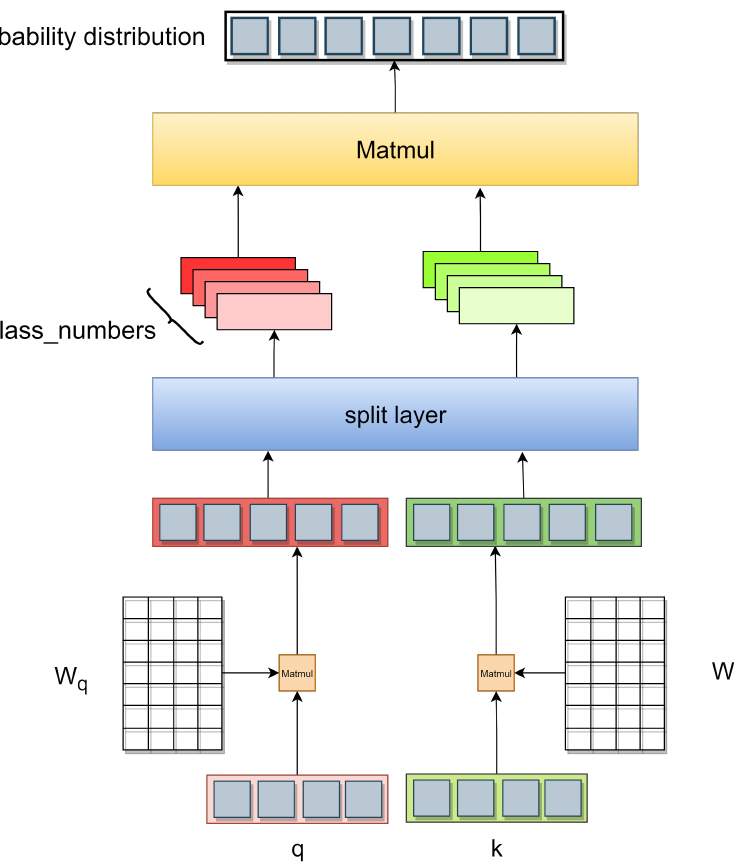
Figure 4. The internal details of Multi-Class Attention are shown. q and k are first calculated with the corresponding parameter matrices; then, they are divided into different q i and k i by the split layer; finally, the probability distribution of each relation class is calculated by